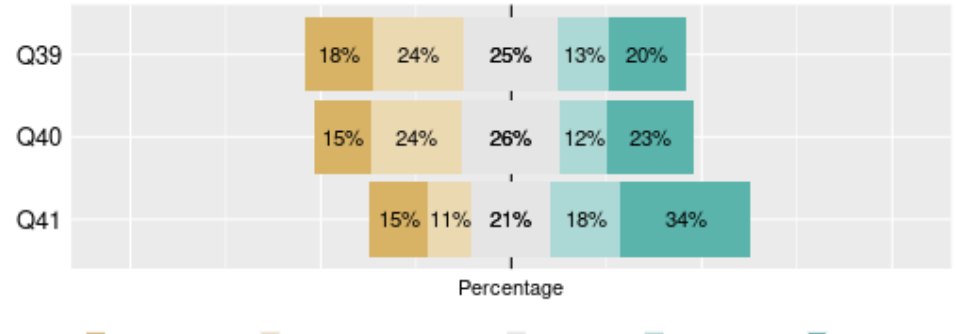
Figure 9. Results related to dimension Data